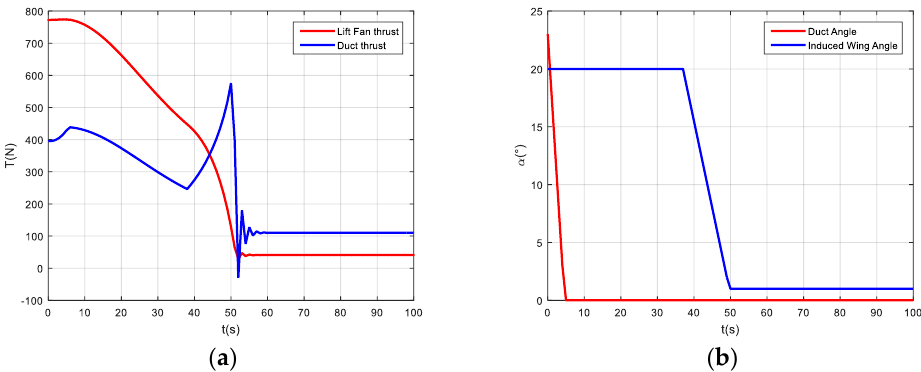
Figure 15. ( a ) Rapid transition of lift fan and lift duct thrust state when arriving at stall speed deflection induced the wing; ( b ) Rapid transition of forward speed and lift duct deflection when arriving at stall speed deflection induced the wing.